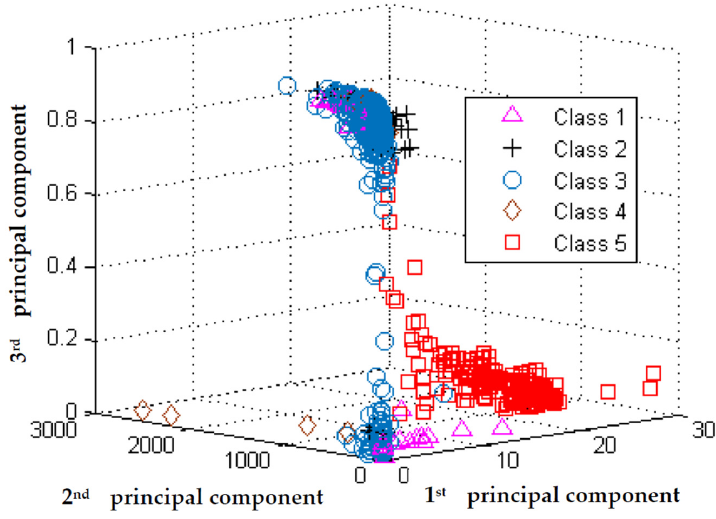
Figure 8. PCA visualization of all feature vectors Z during injection molding cycles.